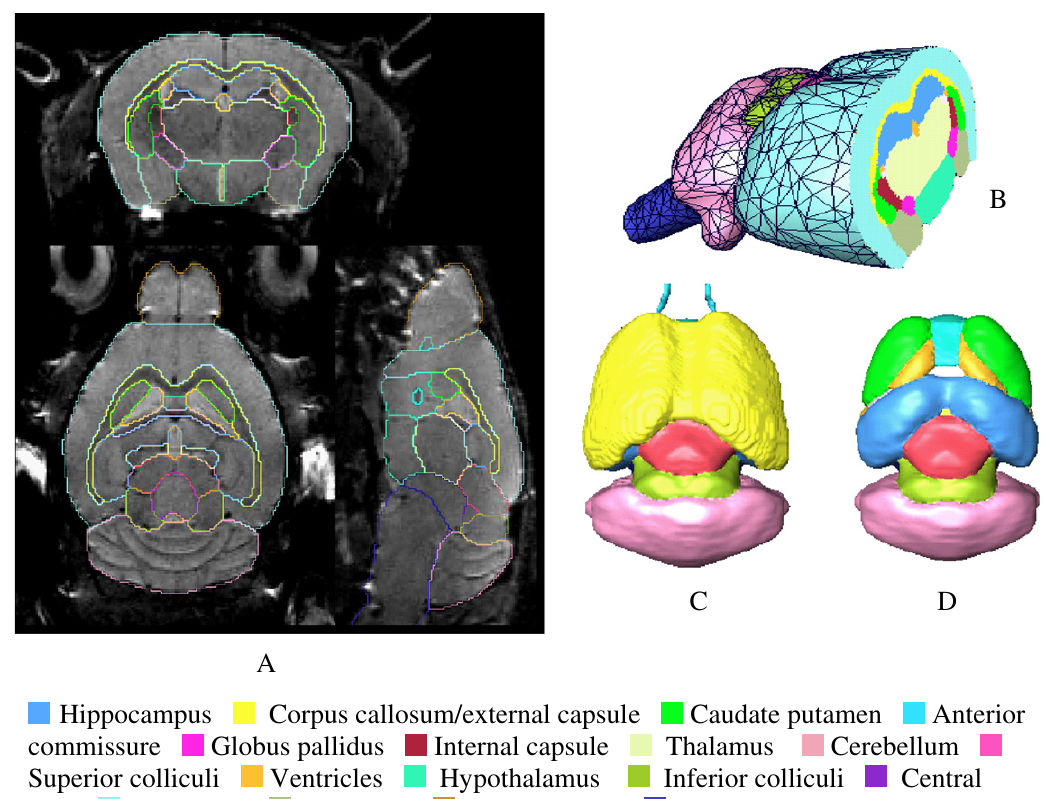
Figure 5. (A) The coronal, axial and sagittal slices of a 3D in vivo MRI mouse brain image with its structural segmentation superimposed as colored lines. (B) 3D surface reconstructed atlas with one cross section. (C) The brain interior with neocortex, olfactory bulb and brain stem hided from the view. (D) Further 3D details with the exterior capsule and the anterior commissure hidden from the view.